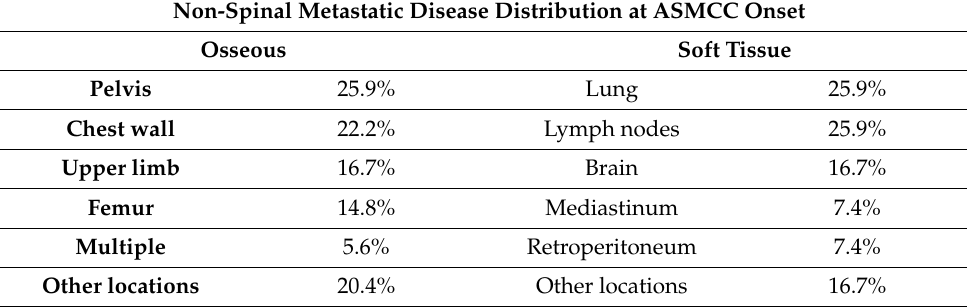
Table 2. Non-spinal metastatic disease distribution at AMSCC